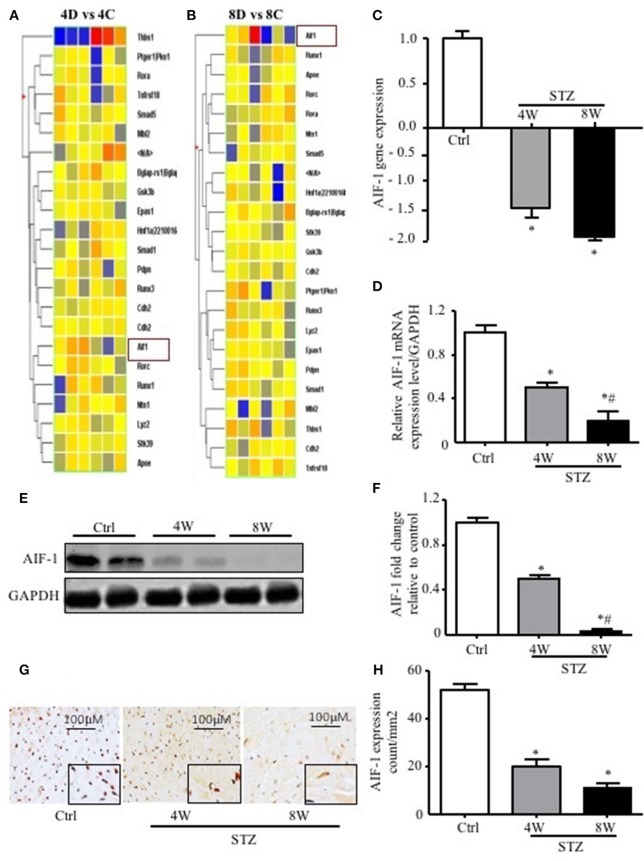
B cell inflammatory gene expression in diabetic mice heat. (A) Heat map represents data of differentially expressed genes in STZ-treated diabetic mice (4D: STZ 4W, 8D: STZ 8W) compared with Ctrl (4C: Ctrl 4W, 8C: Ctrl 8W). Genes were identified by performing t-tests on the large original dataset and comparing each diabetic group with the relative ctrl group. Features with significantly different expression (p < 0.05) were included. The heat map is organized with individual samples arranged along the Y-axis, and the relative ratios of expression are indicated by color. Color intensity is scaled as highest expression corresponding to bright red and the lowest expression corresponding to bright blue. Genes that are up- or down-regulated ≥1.5-fold are displayed in red (up-regulation) and blue (down-regulation) respectively. (B) 1.5-fold change B cell inflammatory gene at 8W heart vs. Ctrl heart, (C) AIF-1 expression from microarray data, (D) qPCR mRNA expression of AIF-1, (E,F) immunoblot expression of AIF-1 and quantification, (G,H) immunohistochemical analysis of AIF-1 and quantification. Data are expressed in mean ± SEM (*p < 0.05 as biological significant level, Ctrl vs. STZ), n = 6. (I,J) A20 B cell line incubated with low glucose (LG; 5 mM) or high glucose (HG; 35 mM) for 48 h. High glucose affects B cell marker expression. (*p < 0.05 as biological significant level, LG vs. HG), n = 4. #p < 0.05 as biological significance level, STZ 4W vs STZ 8W.